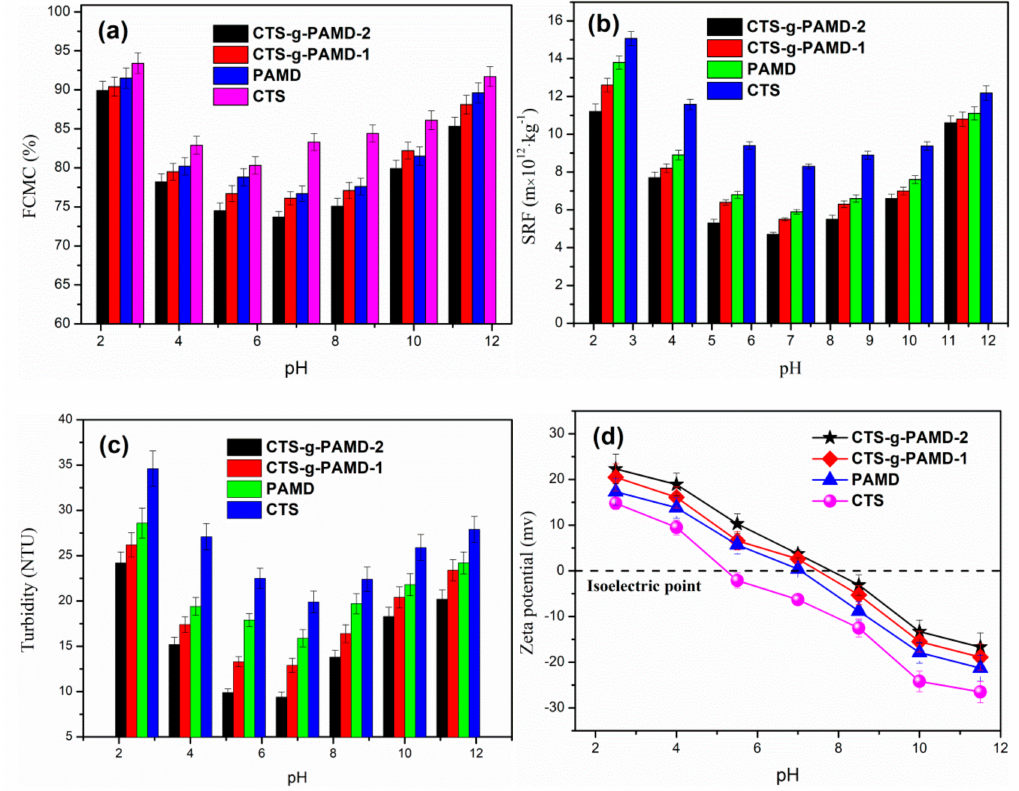
Figure 8. The e ff ect of pH on the sludge flocculation performance: ( a ) FCMC, ( b ) SRF, ( c ) turbidity and ( d ) zeta